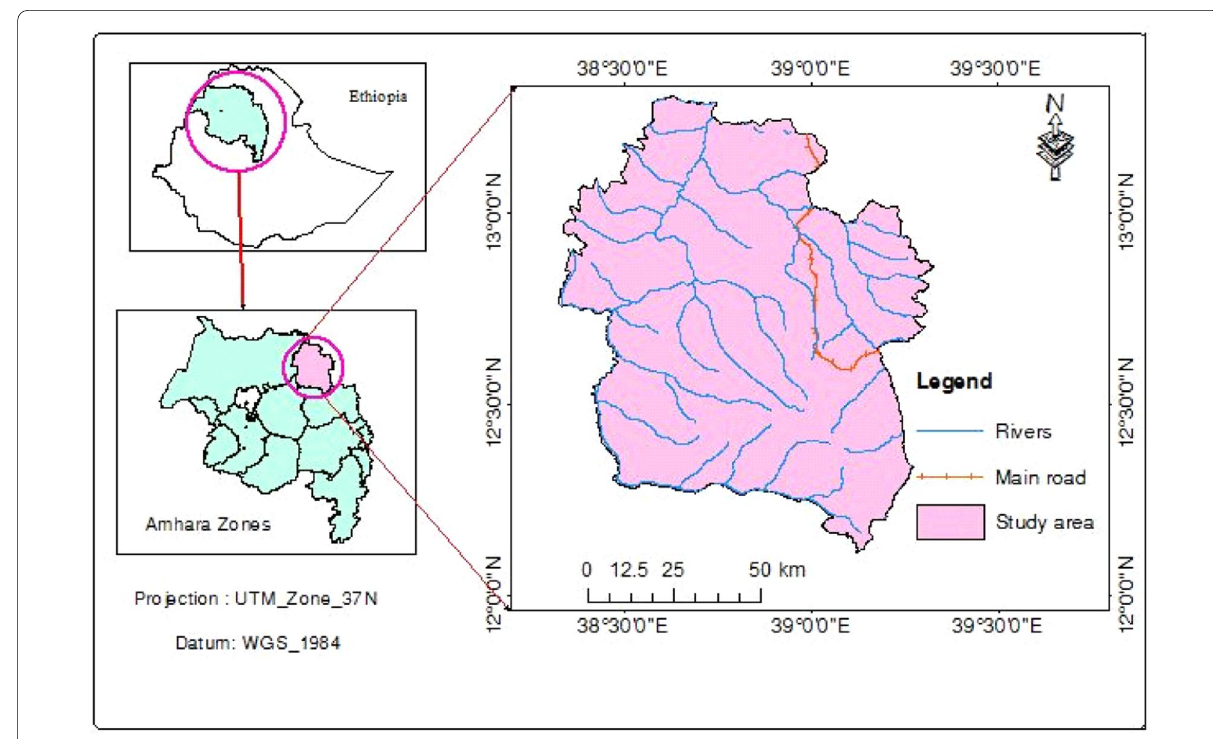
Fig. 1 Location map of the study area